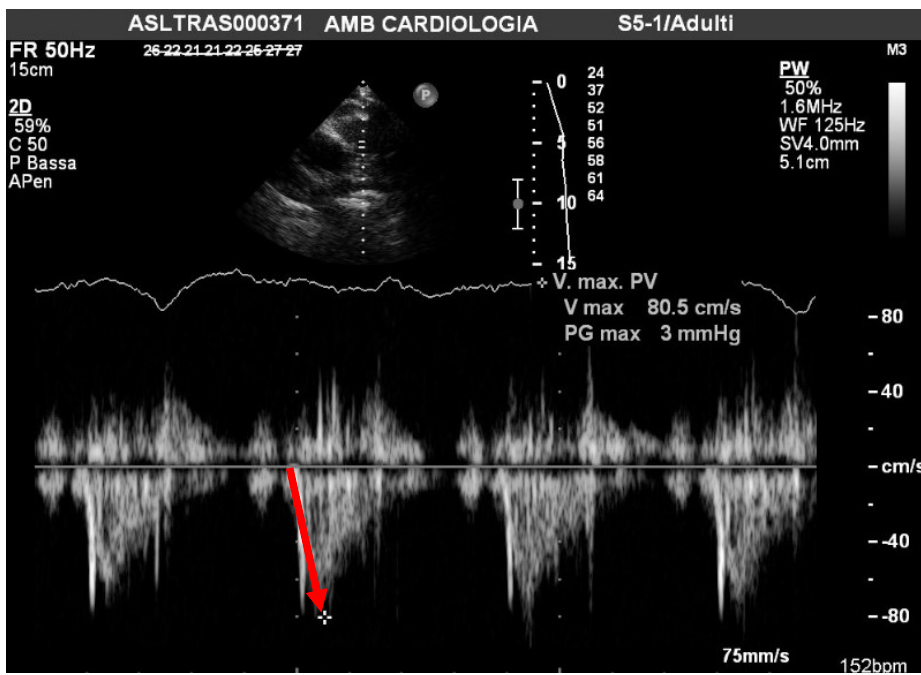
Figure 1. The PAAT was measured by PW-Doppler through the pulmonary valve jet from the short-axis view as the interval (msc) between the onset of ejection and the peak flow velocity. The values were normalized for heart rate (PAAT/HR × 100). RV systolic pressure was determined from the tricuspid regurgitation (TR) jet velocity using the simplified Bernoulli equation and combining this value with an estimate of the correct atrial pressure by the diameter and collapsibility of the inferior vena cava, which was then added to the calculated gradient for the sPAP. All measurements were performed by two blind senior